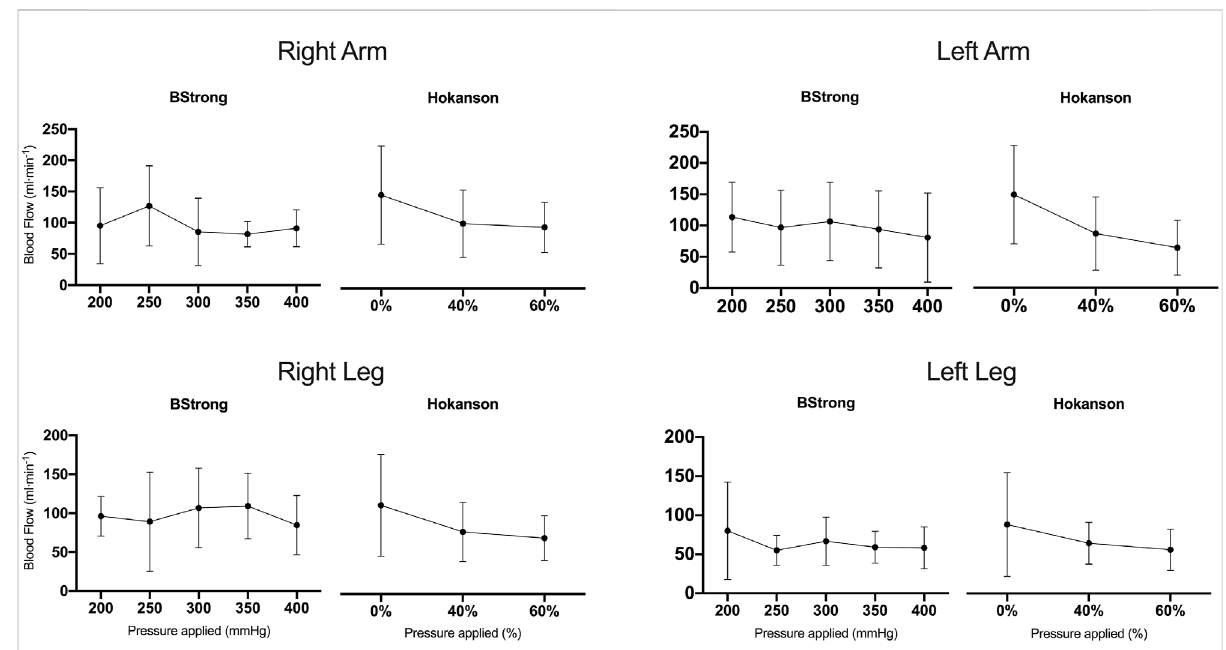
FIGURE 1 Blood fl ow values (mean ± standard deviations) of right arm, left arm, right leg, and left leg. For both arms and legs, BStrong cuffs were in fl ated up at 200, 250, 300, 350, and 400 mmHg while Hokanson cuffs were in fl ated up to 0% (resting values), 40%, and 60% of arterial occlusion